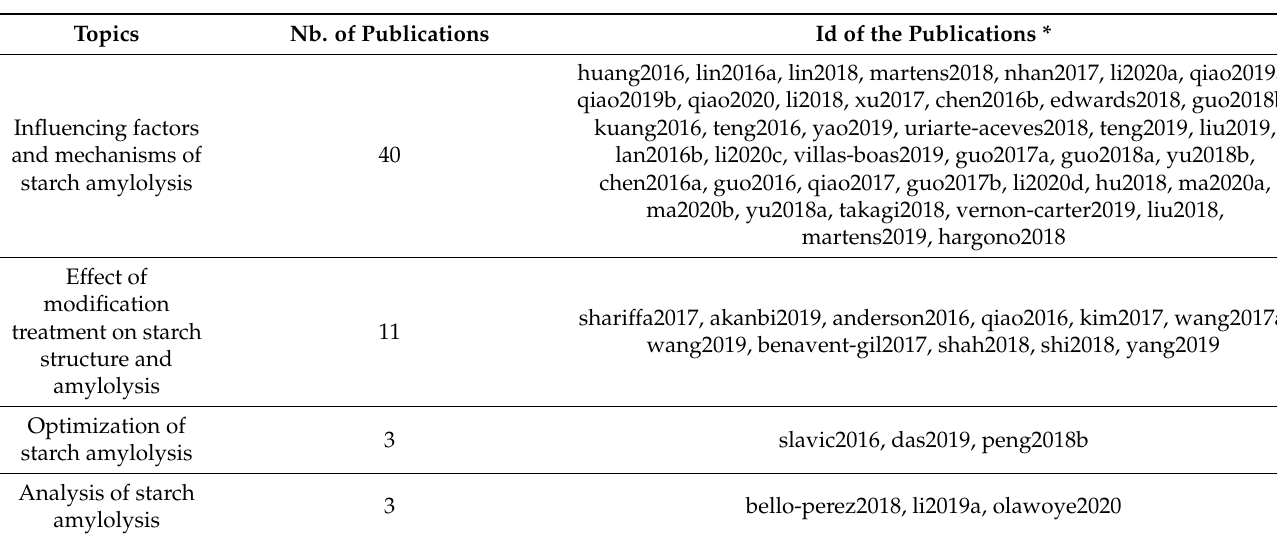
Table 1. Selected articles from 2016 to 2020 sorted by